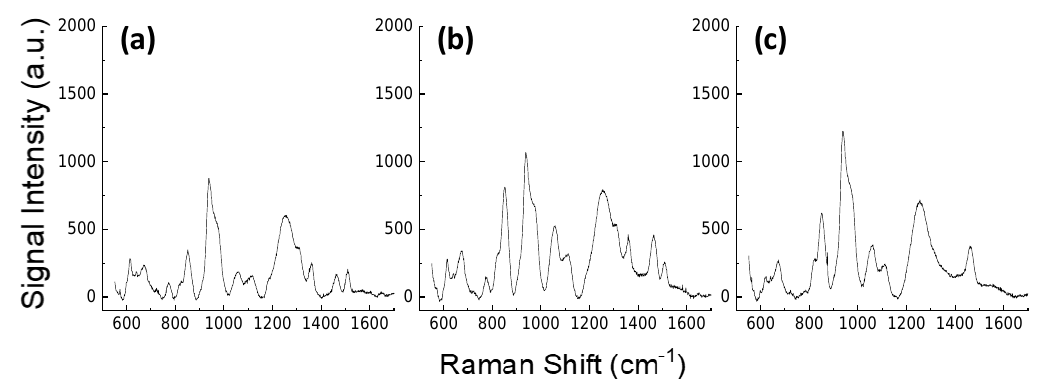
Figure 10. SERS analyses with Au / Si Π structures of blood plasma filtered at 3, 10, and 30 KDa ( a – c , respectively) aiming at characterization of small biomolecules.